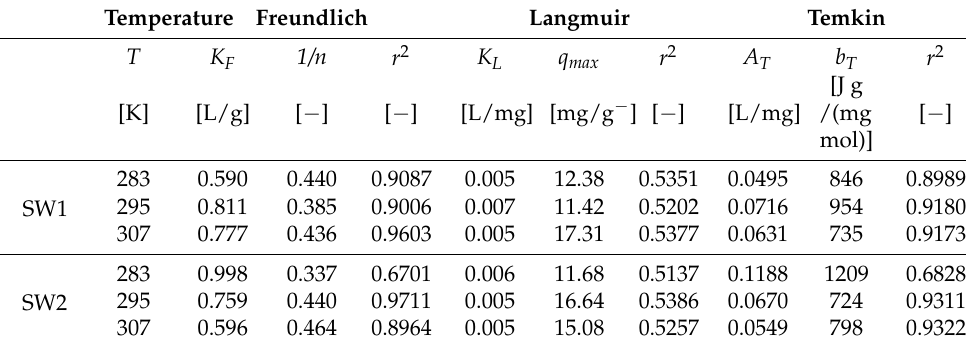
Table 5. Coefficients of isothermal adaptation according to Freundlich, Langmuir and Temkin for CCP 20 after 20 h contact time with SW1 or SW2 at different temperatures (SW1: c 0 = 967